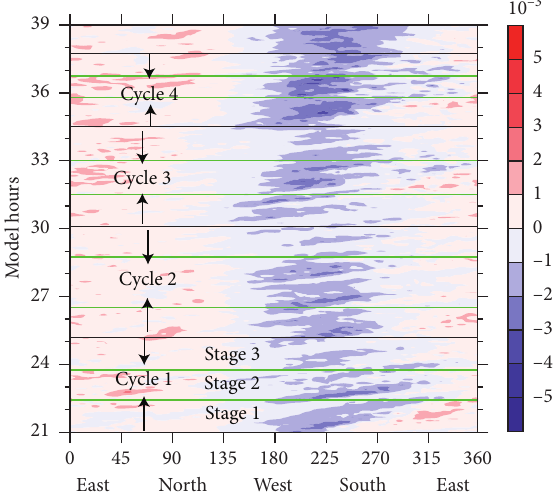
Figure 15: Variation of horizontal divergence at the height of 0.95km with model hours and azimuth. The black lines identify different cycles, and the green lines identify different